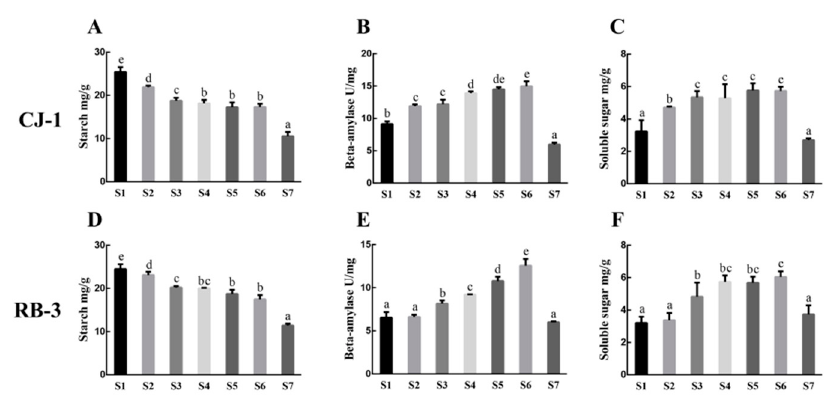
Figure 2. Seasonal changes in starch contents ( A , D ), β -amylase activity ( B , E ), and soluble sugars contents ( C , F ) for shoots of “CJ-1” and “RB-3”. Data are present as means ± standard errors ( n = 3).